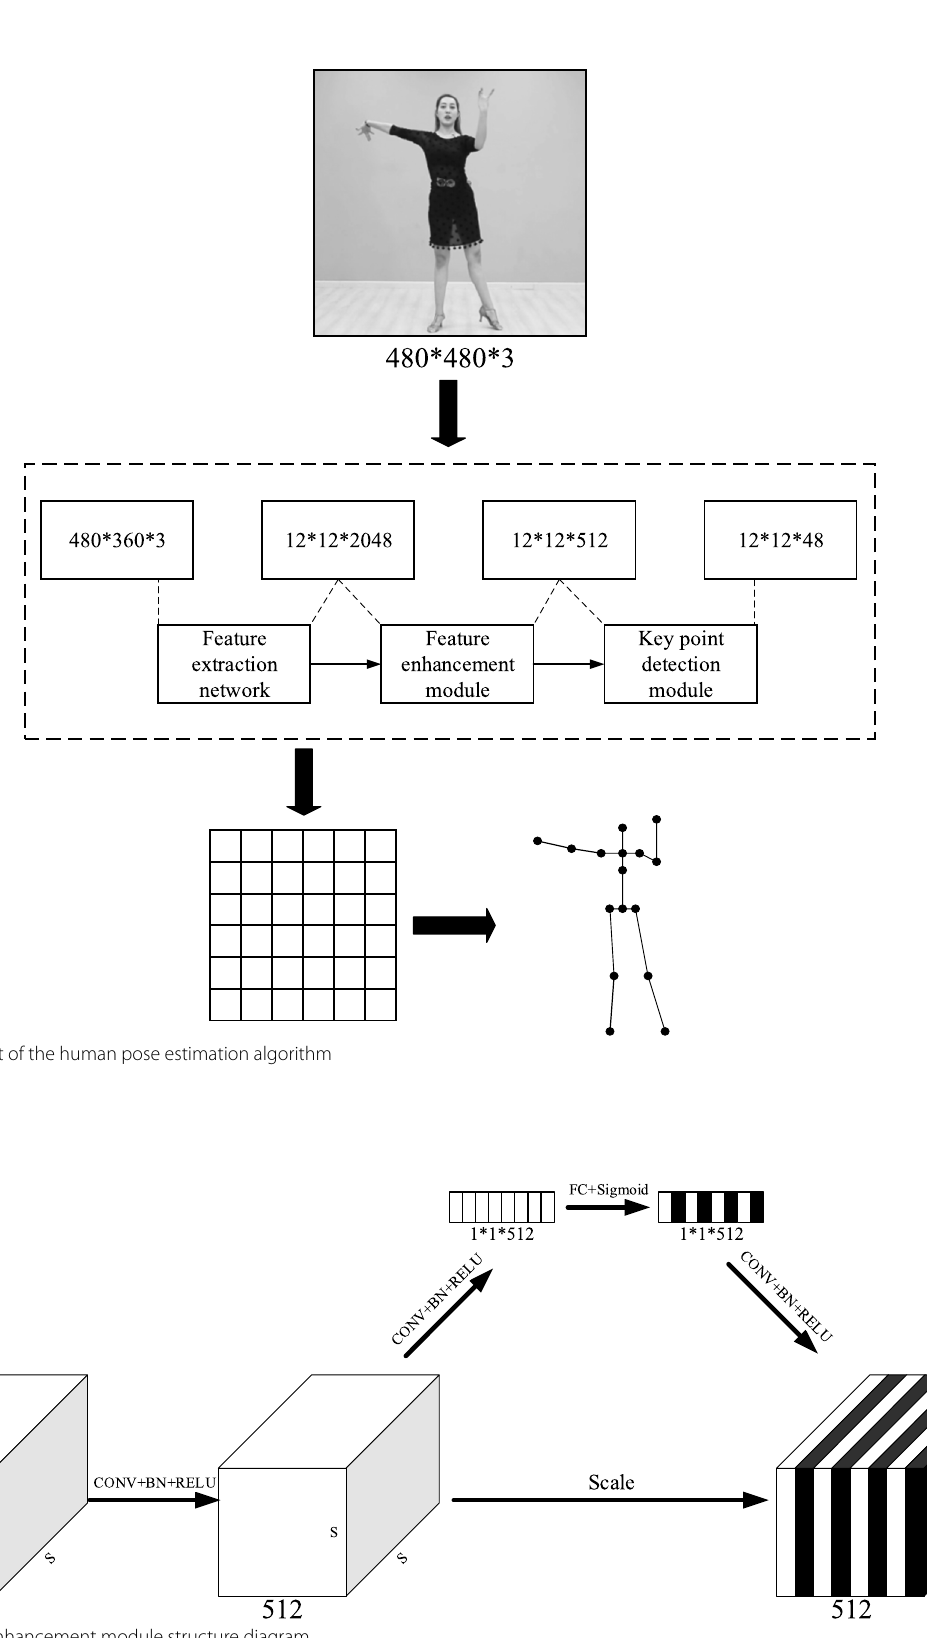
Fig. 9 Feature enhancement module structure